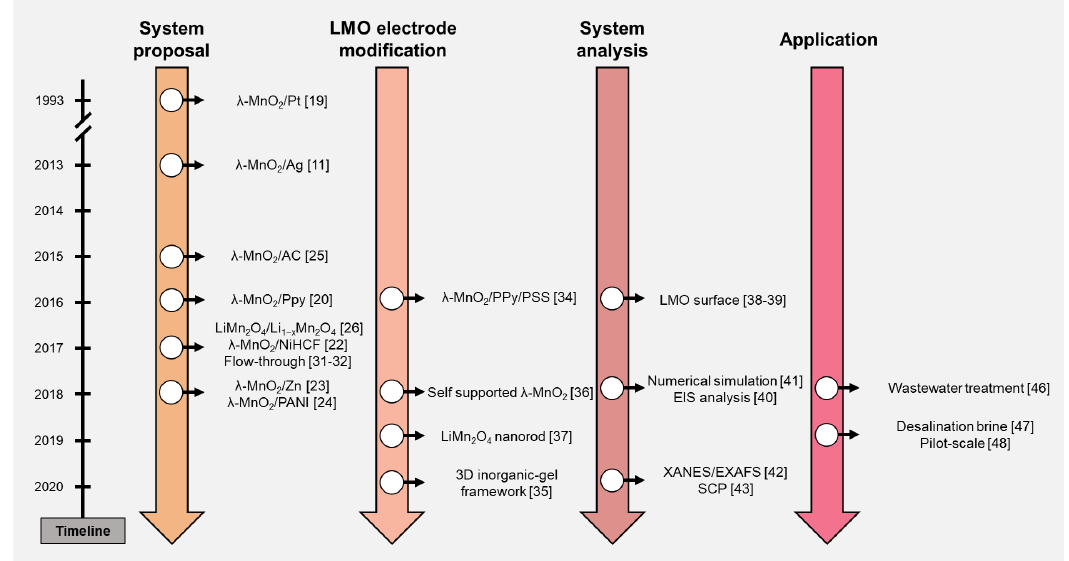
Figure 2. Timeline of the electrochemical lithium recovery (ELR) system research.